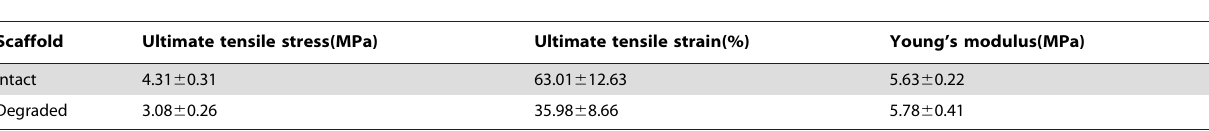
Table 2. The mechanical properties of the scaffold.